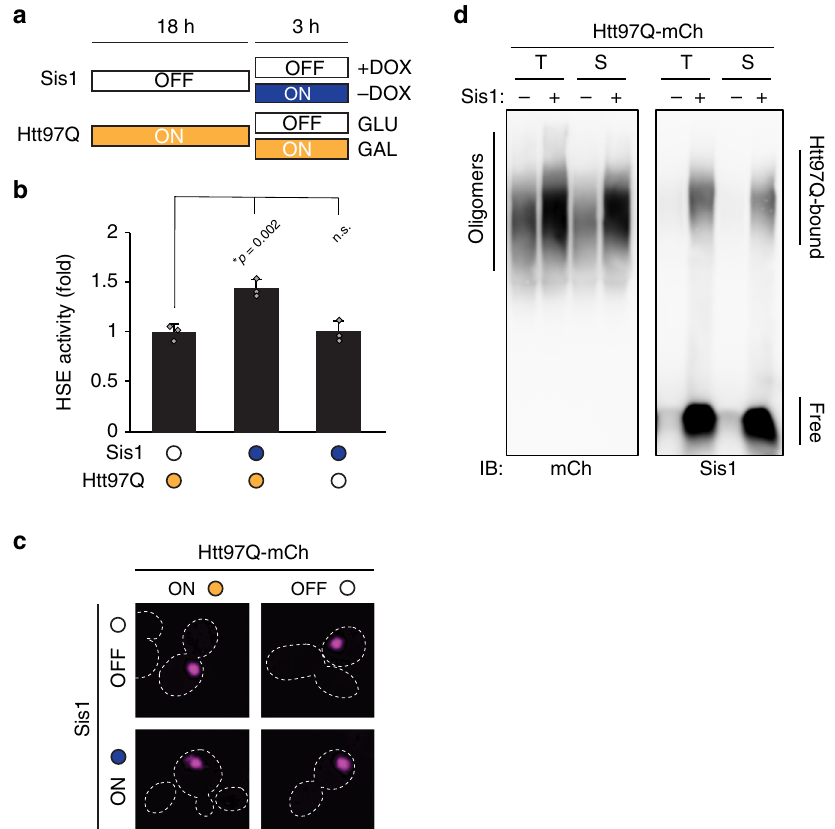
Fig. 4 Sis1 acts on soluble polyQ oligomers. a Experimental scheme for sequential expression of Htt97Q and Sis1. Htt97Q aggregates were allowed to form in the absence of Sis1 overexpression (OFF; white) for ~18 h. Samples were then split and subjected to continued (ON; orange) or repressed (OFF; white) Htt97Q expression (galactose or glucose mediated, respectively), and to normal (OFF; white) or overexpressed levels (ON; blue) of Sis1 (doxycycline mediated), for the fi nal 3 h before harvesting and analysis. b Ongoing Htt97Q expression is required for Sis1 dependent HSR activation. P HSE LacZ activities were measured in strains treated as in a . Htt97Q aggregates were allowed to form in cells by expressing Htt97Q for ~18 h. Htt97Q expression was then continued or repressed for 3 h without or with Sis1 overexpression (orange/empty and orange/blue dots, respectively). In a third reaction, Htt97Q expression was stopped by addition of glucose and Sis1 overexpressed for 3 h (empty/blue dots). Experiments were performed in triplicate. Data represent mean + SD from three independent experiments. * p values were determined by Dunnett ’ s multiple comparisons t -test to Sis1 OFF control. n.s. not statistically signi fi cant. c Transient Sis1 overexpression does not remodel preexisting polyQ aggregates. Confocal microscopy was performed on cells during the conditions described in a . Scale bar = 5 μ m. Experiments were performed in triplicate, representative images shown. d Overexpression of Sis1 increases the level of soluble polyQ oligomers. Total (T) or soluble (S) lysates from cells expressing Htt97Q with or without Sis1 overexpression (as in Fig. 3c) were treated with 2% SDS and analyzed by SDD-AGE (See “ Methods ” section for details). Immunoblotting was performed for mCherry (Htt97Q, left) or Sis1 (right). Representative blots of three independent experiments are shown. Also see Supplementary